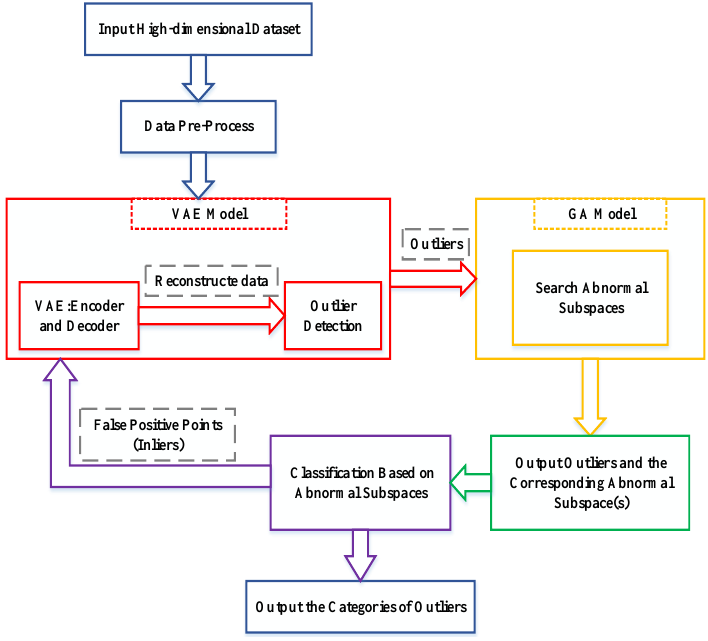
Figure 5. VAEGA model